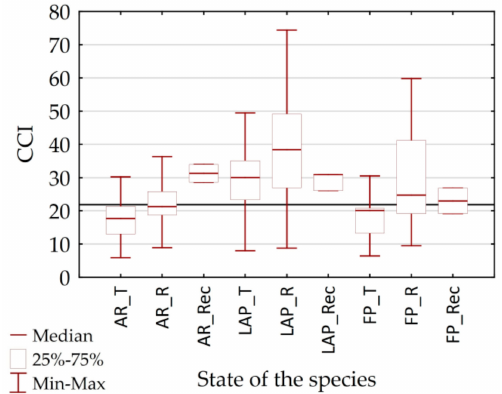
Figure 9. Values of indices: CCI ( Chlorophyll Content Index ), n = 49,375 per